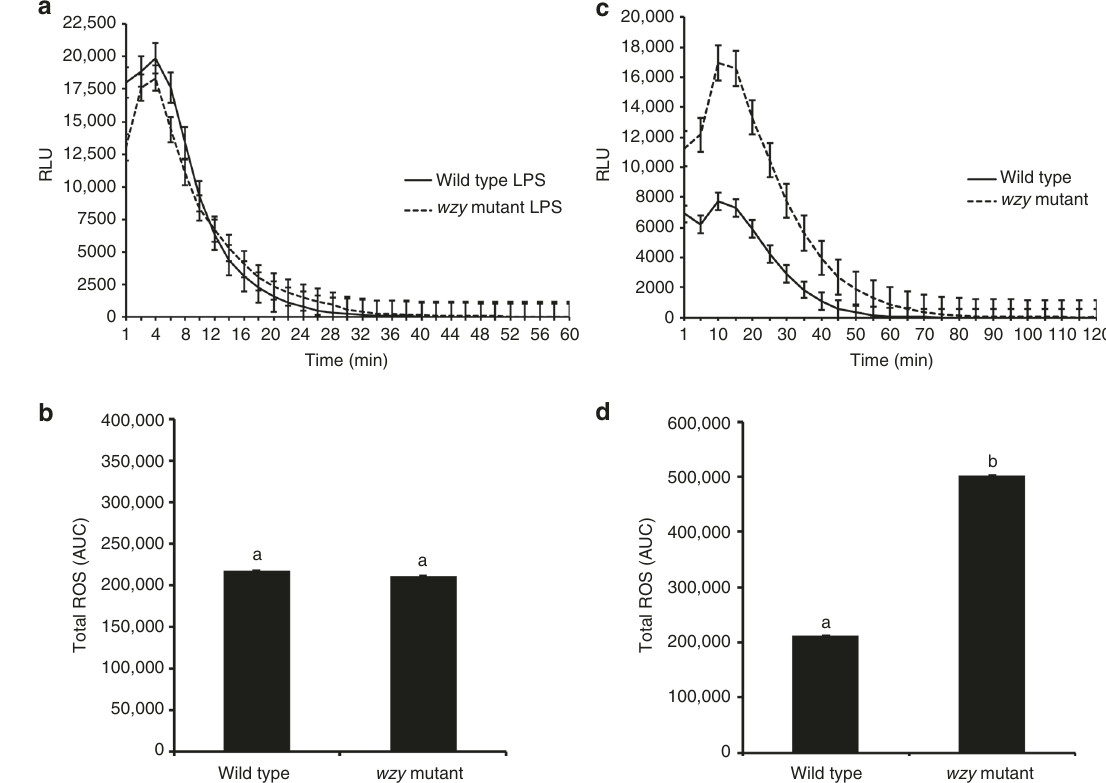
Fig. 1 O-antigen-modulated ROS production by extracted LPS and intact bacterial cells ex vivo. Discs of V. vinifera ‘ Cabernet Sauvignon ’ leaves were treated with 20 μ L of a 50 μ g/mL solution of puri fi ed LPS elicitors (either wzy or wild type LPS) equal to a fi nal amount of 10 μ g (based on Kdo content) of LPS, 20 μ L of a 10 8 CFU/mL suspension of Xf wild type or wzy cells, or diH 2 0 or 1× PBS-inoculated controls, respectively. a The amplitude of ROS production remained similar for both wild type and wzy LPS, reaching max production at ~4 min, and plateaued starting around 30 min. b Total ROS production is reported as area under the curve (AUC) for plot of luminescence intensity over time. Total ROS production was not signi fi cantly different between discs treated with wild type or wzy extracted LPS. c Intact wzy cells induced a signi fi cantly stronger oxidative burst that persisted nearly 20 min longer than leaves inoculated with wild type bacteria (which contained fully polymerized O-antigens). Graphs represent the mean of 24 replicates per treatment ± standard error of the mean. d Total ROS production is reported as area under the curve (AUC) for plot of luminescence intensity over time. Discs treated with wzy cells produced signi fi cantly more ROS than discs treated with wild type cells. Graphs represent the mean of 24 replicates per treatment ± standard error of the mean. Treatments with different letters over the bars are statistically different ( P < 0.05, Mann – Whitney U test, n = 24